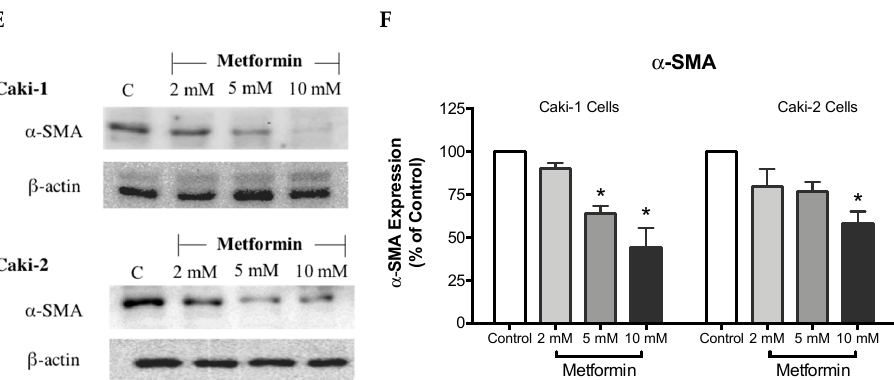
Figure 4. Metformin inhibited cell migration and invasion in both Caki-1 and Caki-2 cells. In vitro scratch migration assay at 0, 6 and 24 h following metformin treatment (5, 10, 20, and 50 mM) are shown in ( A ) Caki-1 cells ( B ) and Caki-2 cells. Images are representative of three independent experiments in each group. Pooled quantified normalized data expressed as gap reduction (percentage of control) is presented for ( C ) Caki-1 and ( D ) Caki-2. ( E ) Western blot analysis of the expression of α -SMA in Caki-1 and Caki-2. Images are representative of n = 4–5 per group. ( F ) Histograms represent pooled densitometry data normalized to β -actin expressed as the percentage of control. Data are presented as mean ± SEM. * P < 0.05 vs. control.